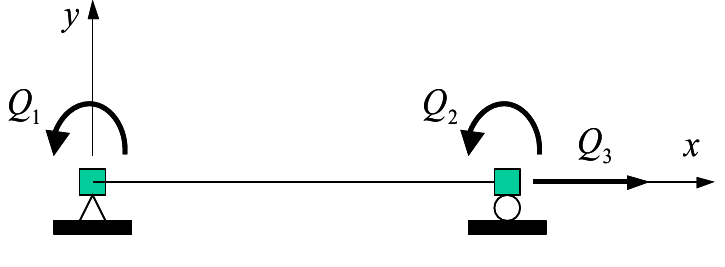
Figure 7. FE without rigid body modes. Denoting with increments of the corresponding quantities, the section deformation D ( x ) and section force fields d ( x ) could be expressed, Equations (1) and (2):